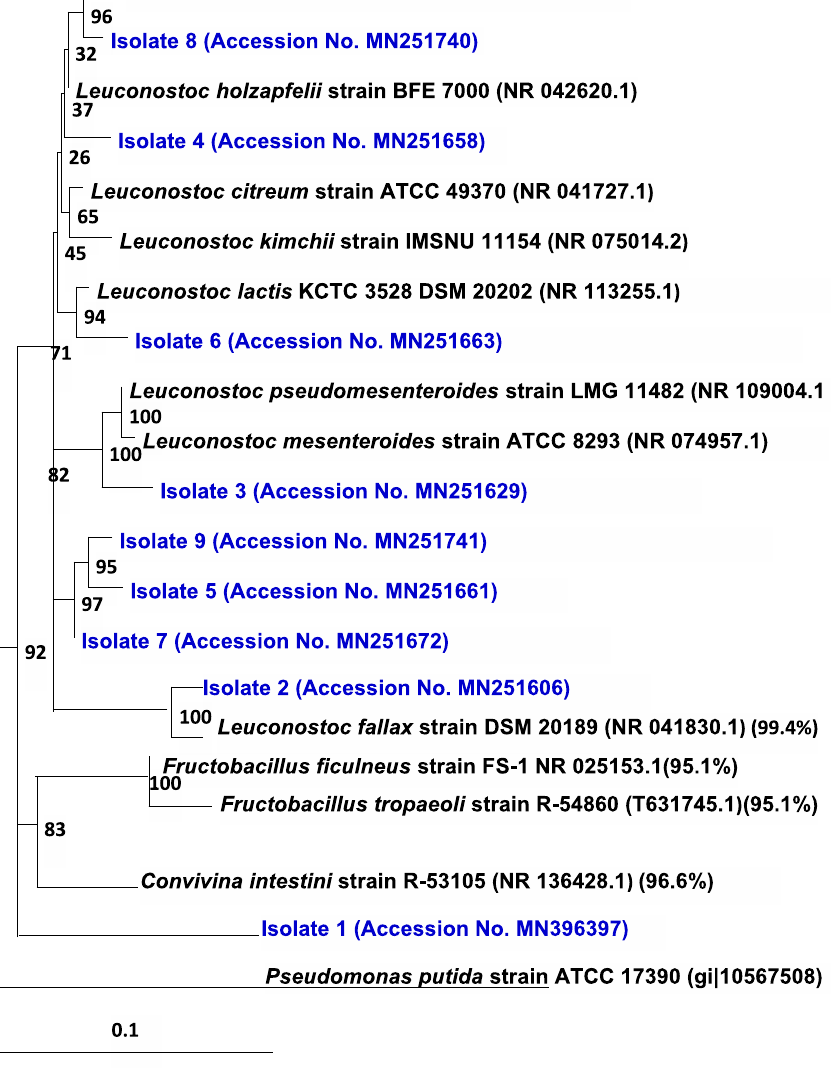
Fig. 1 . Neighbor-joining tree showing the estimated phylogenetic relationship of the Exopolysaccharide producing bacterial isolates (shown in blue) and other closely related strains of the genus Leuconostoc . Bootstrap values out of 100 are given at the nodes. Pseudomonas putida strain ATCC 17390 (gi|10567508) was used as out